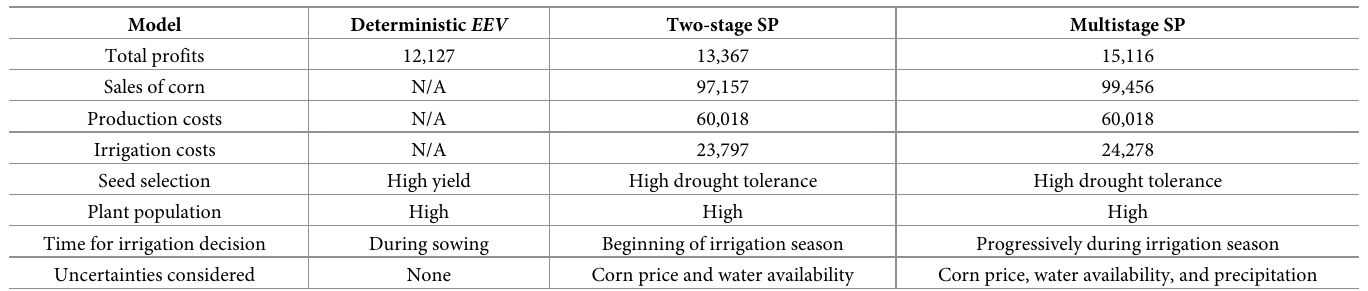
Table 3. Comparison among different models